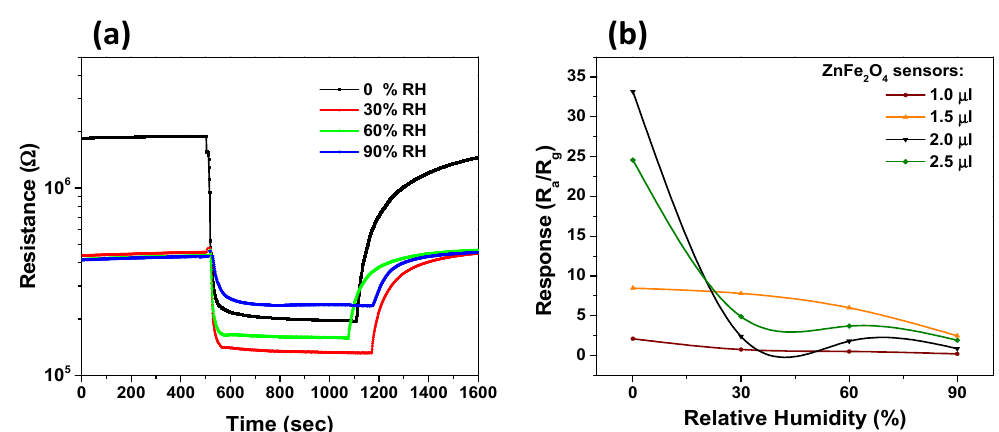
Figure 9. ( a ) Transient resistance curves of the active ZnFe 2 O 4 NP sensing layer produced at 2.0 µL towards 40 ppm propanol at an operating temperature of 120 °C. ( b ) Response against RH of the active ZnFe 2 O 4 NP sensing layer produced at different deposition volumes of 1.0, 1.5, 2.0, 2.5 µL.